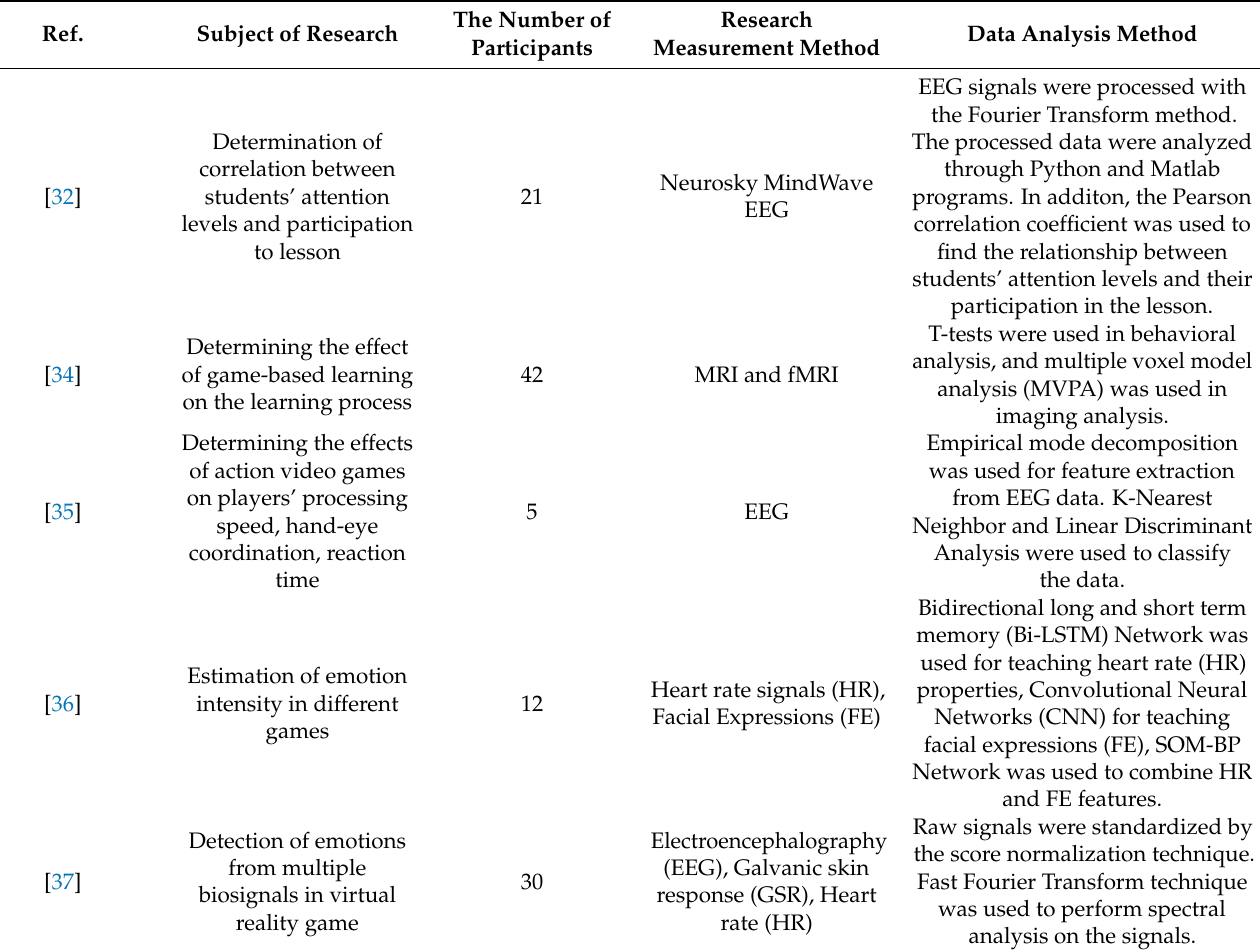
Table 1. Studies using bio signals in gaming and education environments.